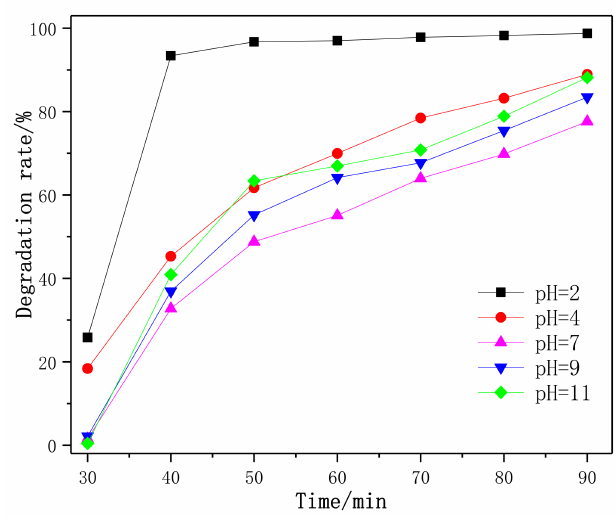
Figure 9. The time-dependent curve of degradation rate of methyl orange by Ag-TiO 2 at di ff erent